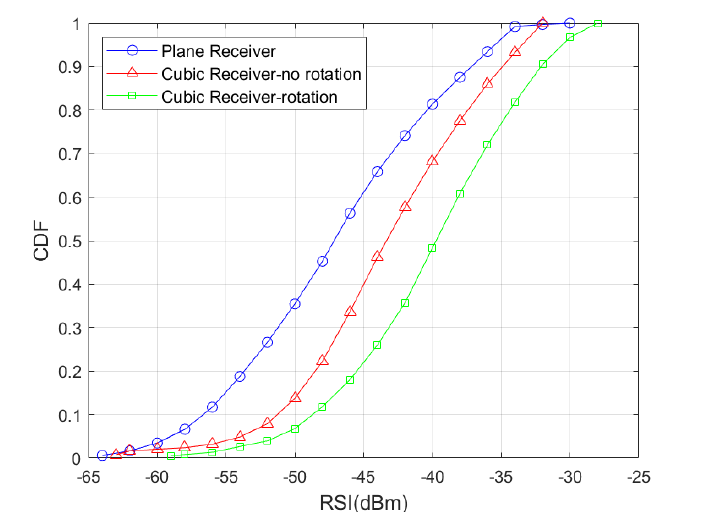
Figure 7. The CDF of RSI for Φ 1/2 = 60 ◦